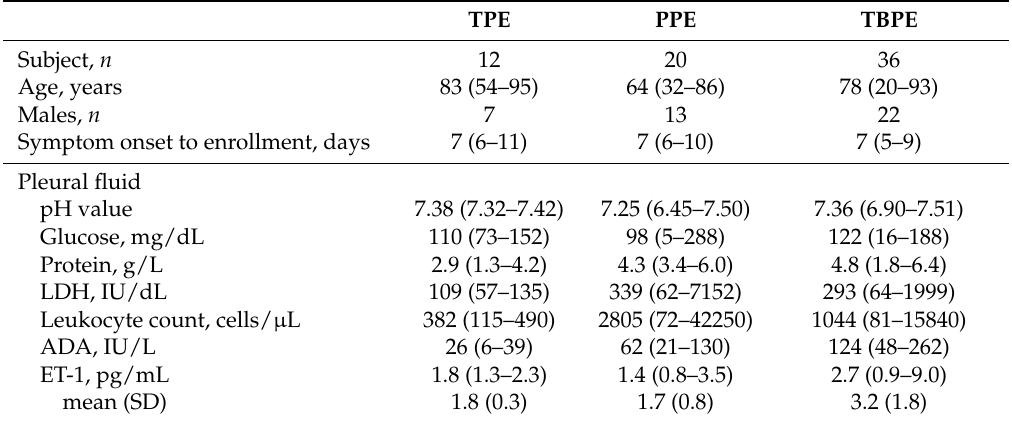
Table 1. Demographics and pleural fluid characteristics and ET-1 levels among all patients ( n = 68) † .